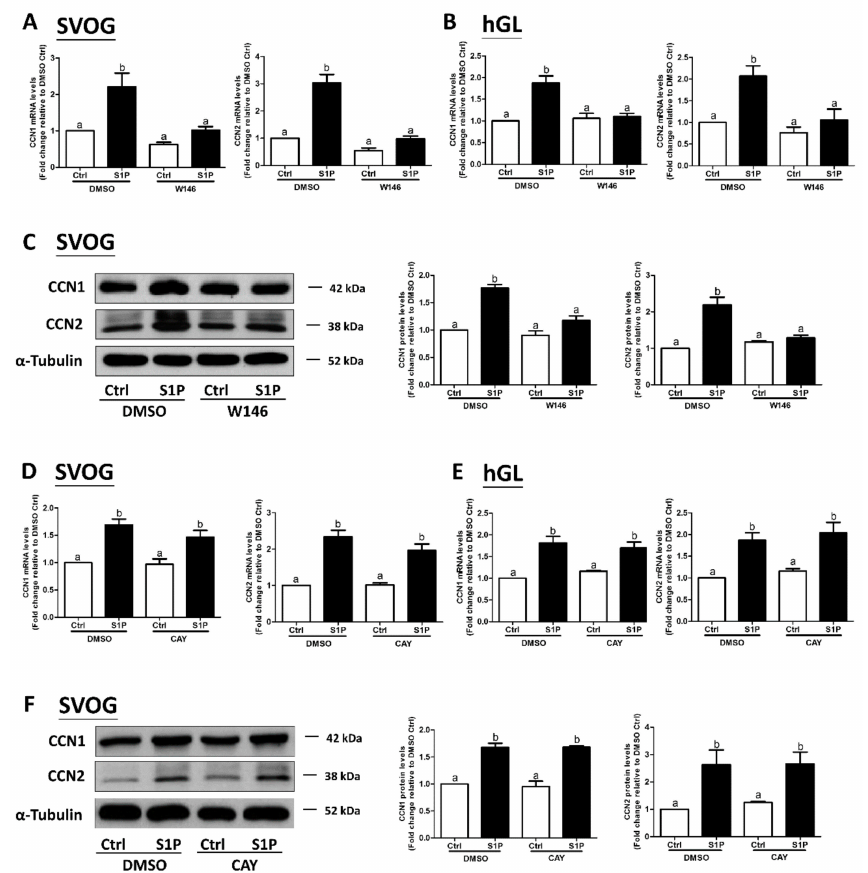
Figure 3. The S1P 1 receptor antagonist W146 abolishes the S1P-induced upregulation of CCN1 and CCN2 in human granulosa-lutein cells. SVOG cells ( A ) and primary human granulosa-lutein (hGL) cells ( B ) were pretreated with a vehicle control (DMSO) or 10 µ M W146 (an antagonist of S1P 1 ) for 1 h and then treated with a vehicle control or 0.3 µ M S1P for 1 h. The mRNA levels of CCN1 ( A ) and CCN2 ( B ) were examined using RT-qPCR. ( C ) SVOG cells were pretreated with a vehicle control or 10 µ M W146 for 1 h and then treated with a vehicle control or 0.3 µ M S1P for 2 h. The protein levels of CCN1 and CCN2 were examined using western blot analysis. SVOG cells ( D ) and primary human granulosa-lutein cells ( E ) were pretreated with a vehicle control or 10 µ M CAY10444 (an antagonist of S1P 3 ) for 1 h and then treated with a vehicle control or 0.3 µ M S1P for 1 h. The mRNA levels of CCN1 and CCN2 were examined using RT-qPCR. ( F ) SVOG cells were pretreated with a vehicle control or 10 µ M CAY10444 for 1 h and then treated with a vehicle control or 0.3 µ M S1P for 2 h. The protein levels of CCN1 and CCN2 were examined using western blot analysis. The results are presented as the mean ± SEM of at least three independent experiments. If a pair of values is significantly di ff erent ( p < 0.05), the values have di ff erent subscript letters (a vs. b or b vs. c) assigned to